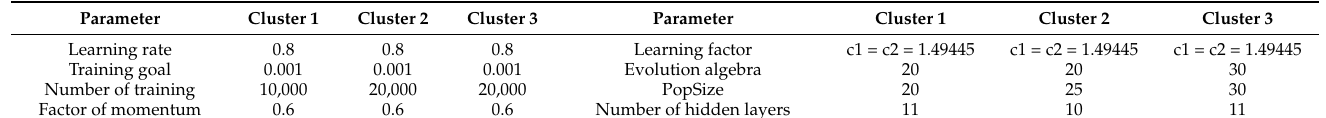
Table 7. Best training parameters of PSO-BP under different clusters.